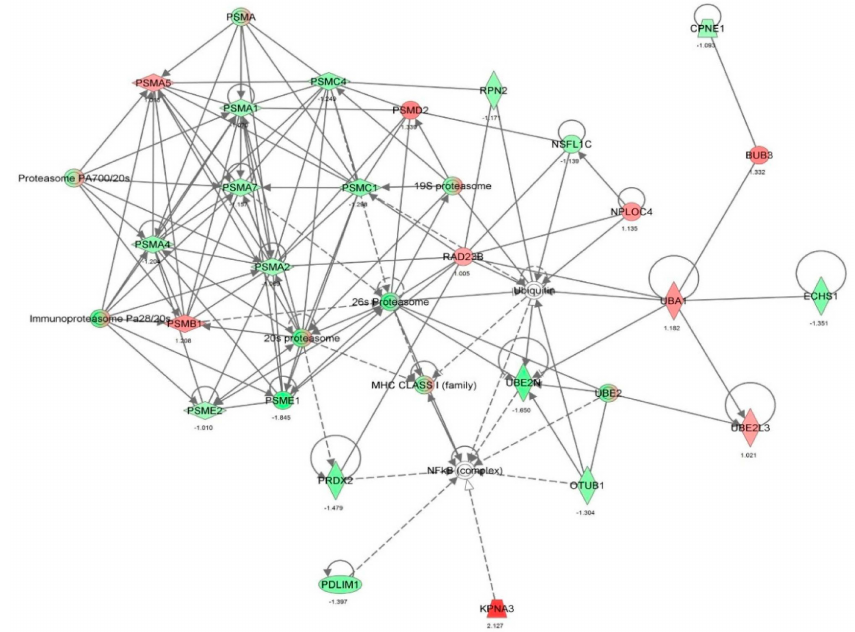
Figure 8. Vancomycin regulated infectious disease, organismal injury and abnormalities, and immunological disease. Red indicates an up-regulation; green indicates a down-regulation. The intensity of green and red colors indicates the degree of down- or up-regulation. Solid arrow indicates direct interaction and dashed arrow indicates indirect interaction.